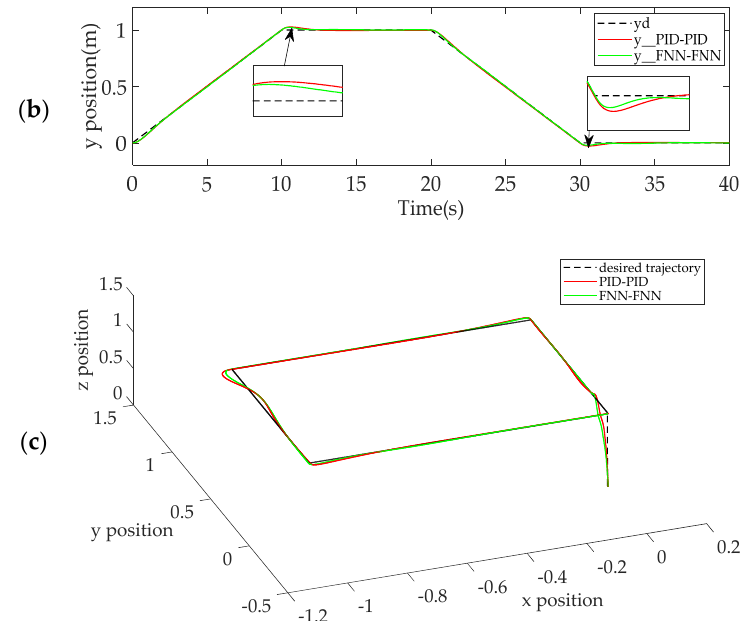
Figure 8. Results of square trajectory simulation. ( a ) x position, ( b ) y position, and ( c ) 3D square trajectory tracking.